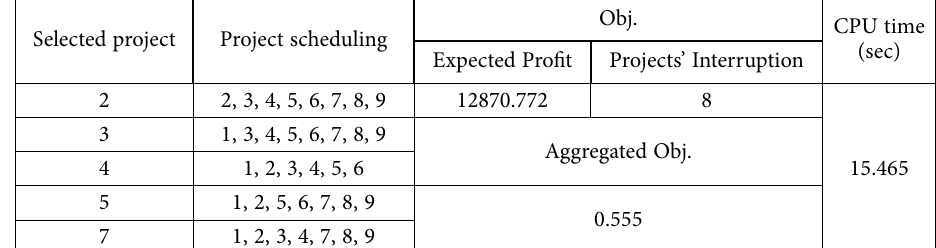
Table 4. The result of the third scenario Selected project